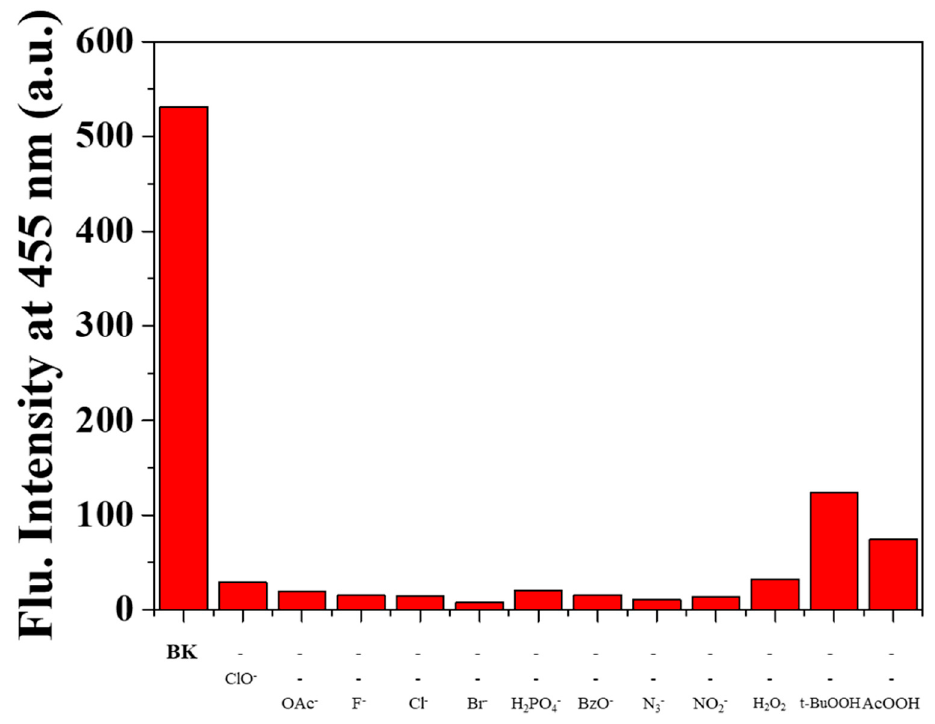
Figure 6. Competitive selectivity of BK (1 × 10 − 5 M) to ClO − (220 equiv) with other analytes (220 equiv). The pH was a vital condition related with physiological processes and even cellular behaviors.